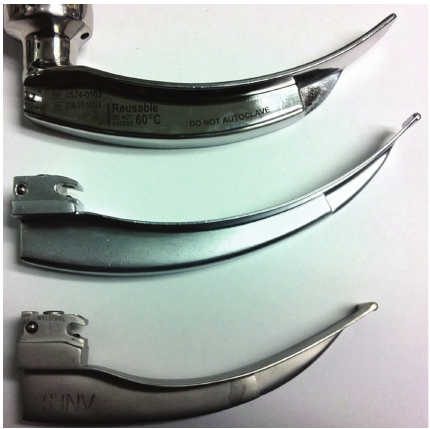
Figure 2: From top to bottom, comparison of the GlideScope Direct blade (top), Macintosh size 4 blade (middle), and a Macintosh size 3 blade